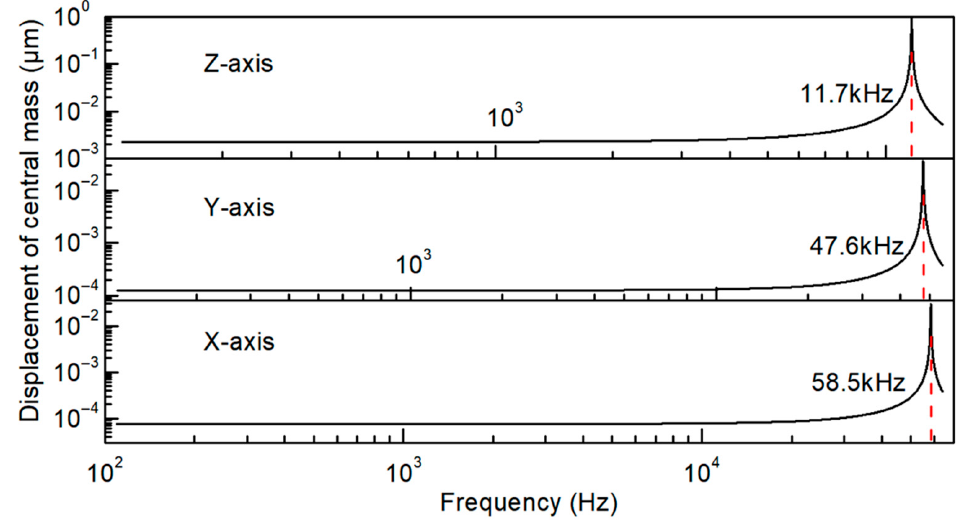
Figure 4. The frequency response of the tri-axial accelerometer: displacement vs. frequency.